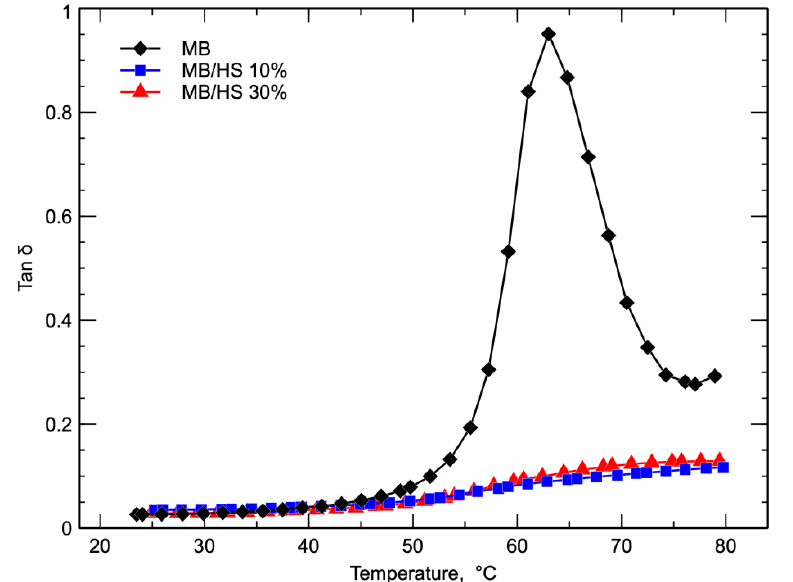
Figure 8. Tan δ curves of MB and biocomposites.